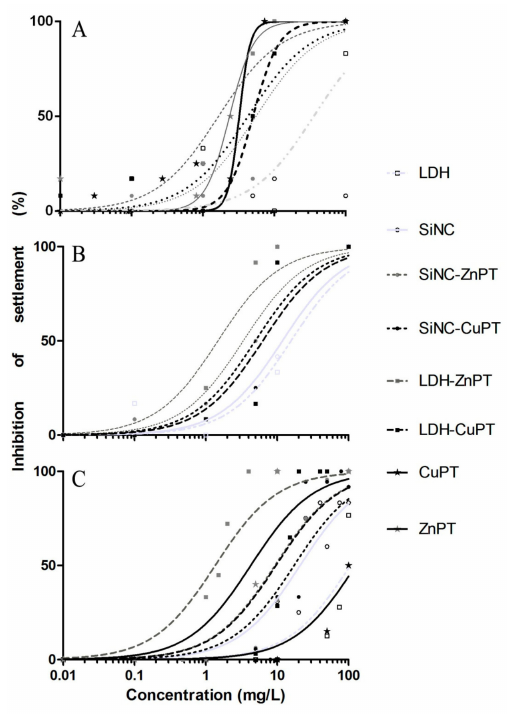
Figure 1. Antimacrofouling efficacy assays following exposure to different concentrations of ENMs on the Atlantic mussel Mytilus galloprovincialis (( A ), ATL), and on Brachidontes pharaonis from the Mediterranean Sea (( B ), MED) and the Red Sea (( C ), RED). ZnPT and CuPT for MED are not presented.